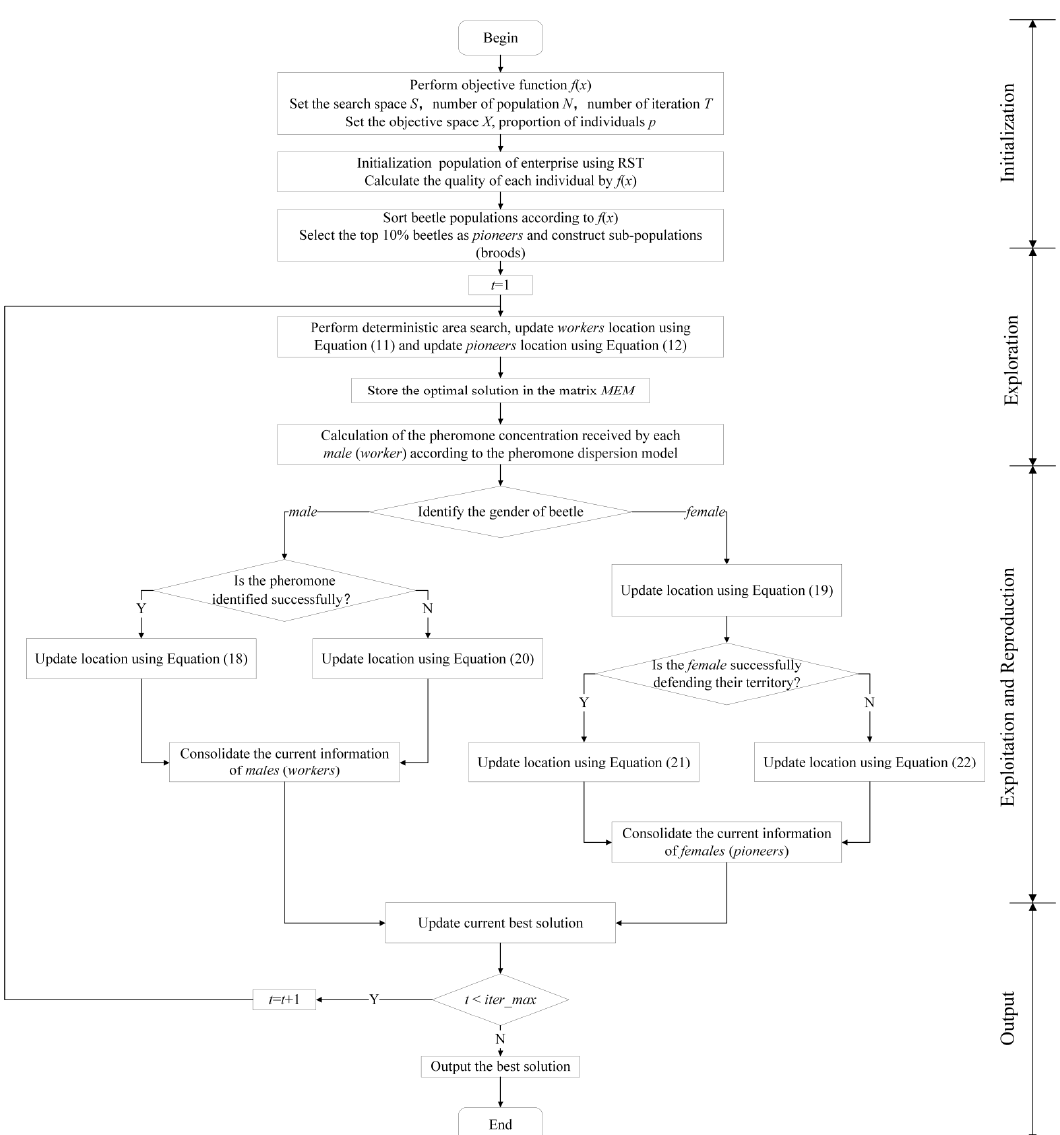
Figure 7. Flowchart of PBA-PDM.